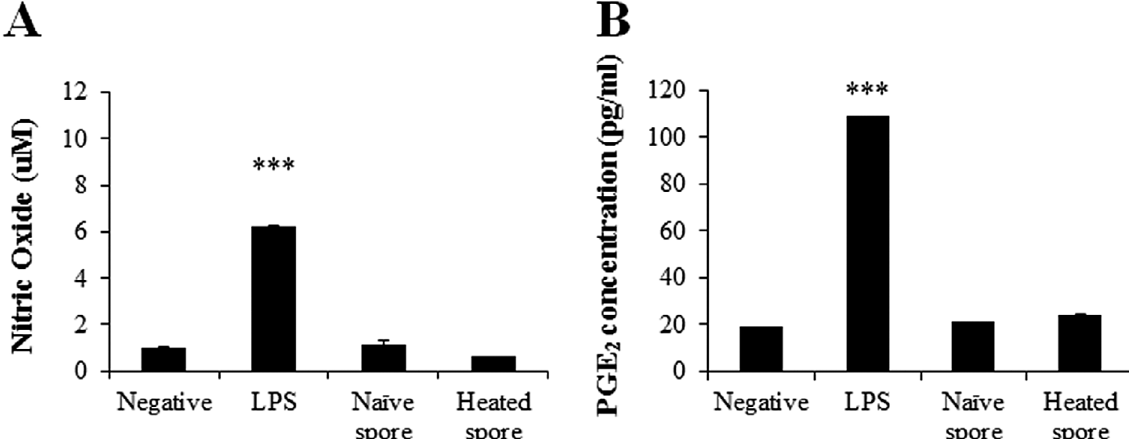
Figure 5. Effects of Kudoa septempunctata spores on nitric oxide (NO) (A) and prostaglandin E2 (PGE 2 ) (B) production in Caco- 2cells. Data are presented as mean ± SE of three independent experiments performed in triplicate. *** p < 0.001 vs. negative